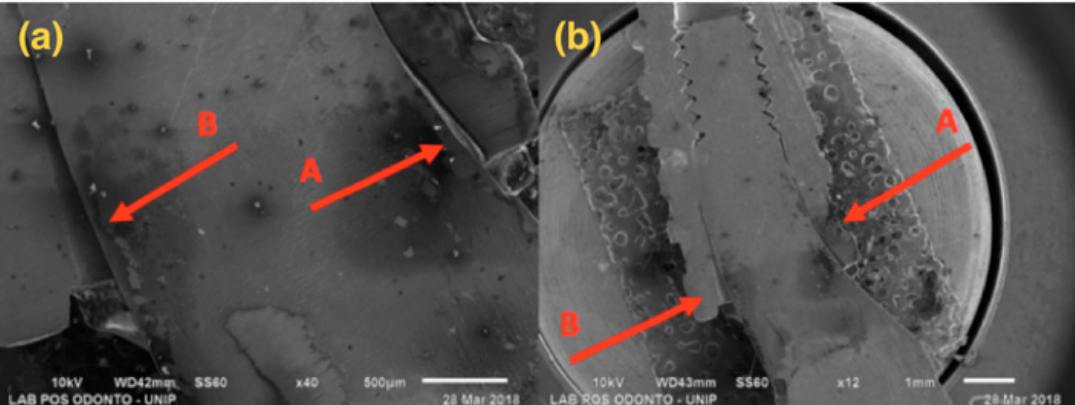
Figure 6. G3: SEM: ( a ) Magnification of 40 × ; ( b ) Magnification of 12 × ; A—Compression at the abutment / implant interface; B—Opening at the abutment / implant interface.